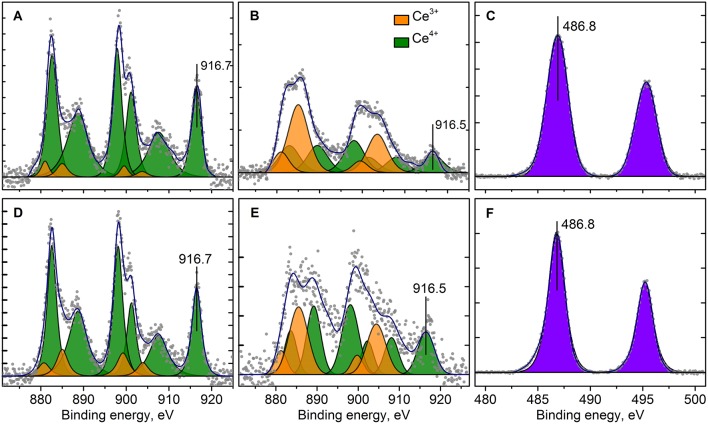
Curve fitted Ce3d (A,B,D,E) and Sn3d (C,F) XPS spectra for Pt/Ce-600 (A,D), Pt/CeSn-600 (B,C,E,F) before (A,B,C) and after CO+O2 reaction (D,E,F) respectively. Ticks range on the Y-axis is 500 counts.